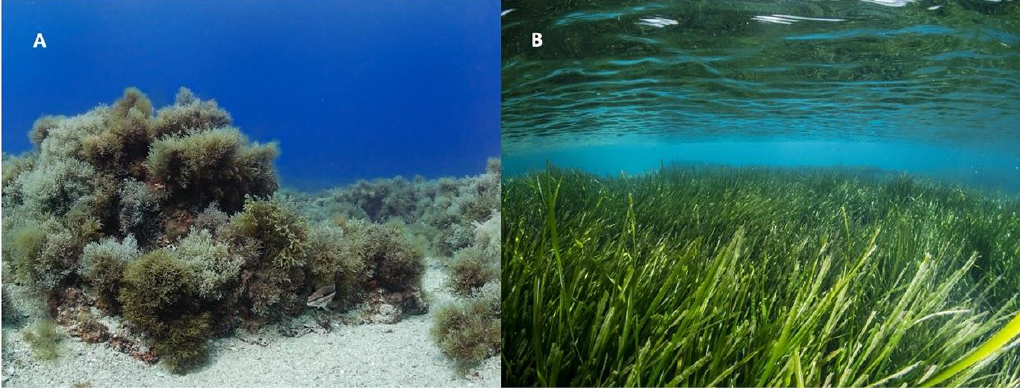
Figure 1. Cystoseira sensu latu community ( A ), Posidonia oceanica meadow ( B ).